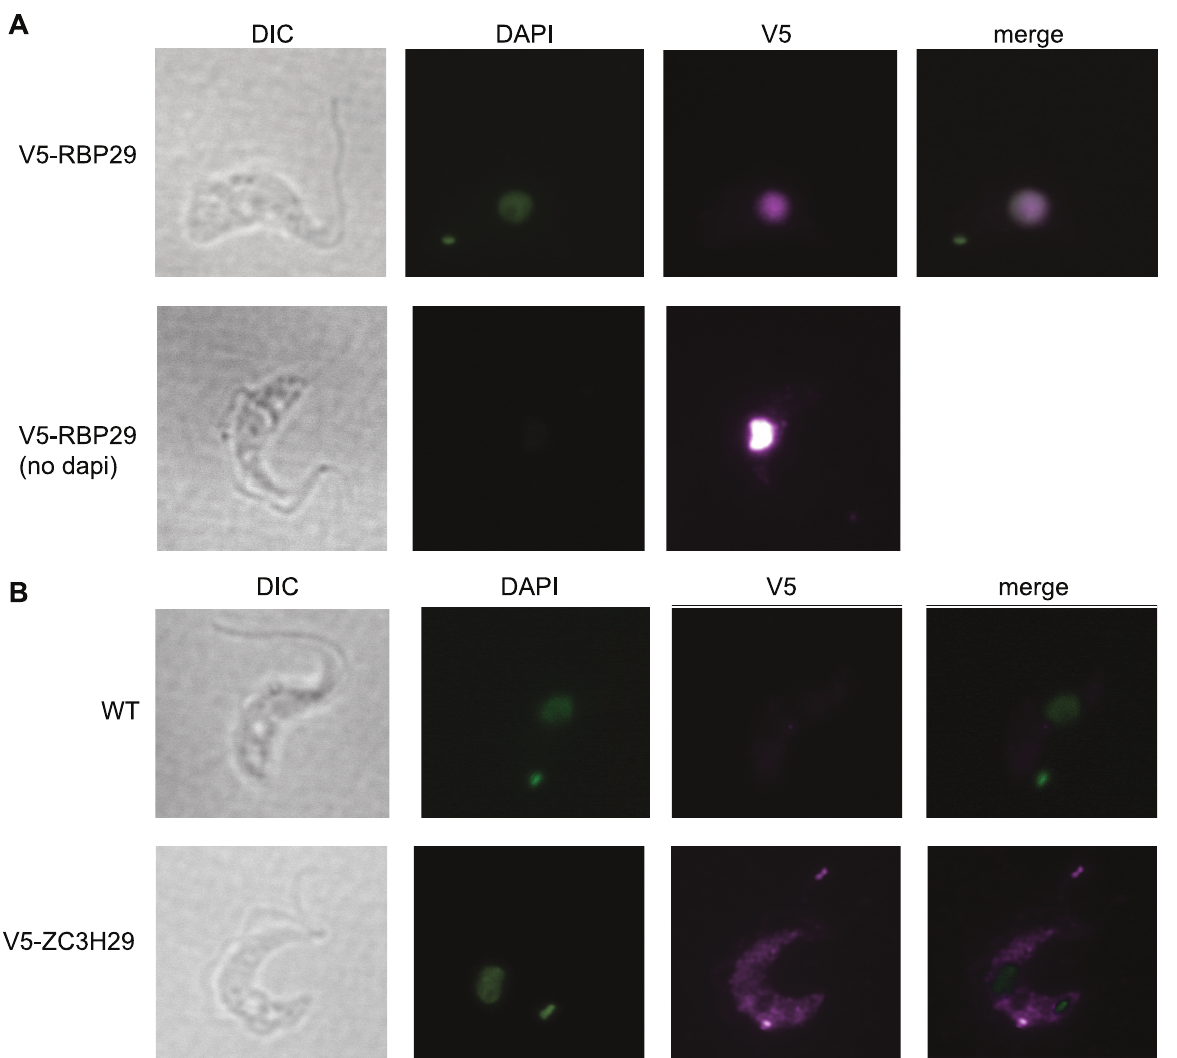
Fig 2. Locations of V5-RBP29 and V5-ZC3H29. (A) An RBP29 gene was tagged in situ with a sequence encoding a V5 tag, in bloodstream forms. The tag was detected using anti-V5 antibody, with or without DNA staining with DAPI. Cells were shown as differential interference contrast (DIC) images. (B) Location of V5-ZC3H29 by immunofluorescence. Details as for